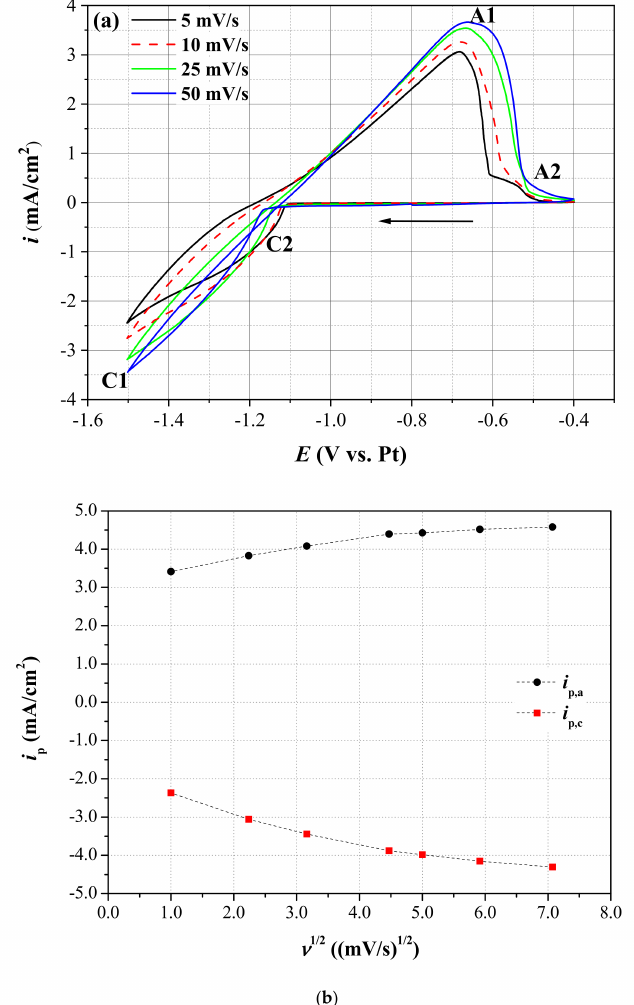
Figure 3. ( a ) Cyclic voltammograms for a Ni WE in [HMIm][TFSI]–(8 M)AlCl 3 at room temperature and at different scan rates. ( b ) The dependence of the anodic and cathodic peak current densities ( i p ) on the square root of the scan rate ( ν 1/2